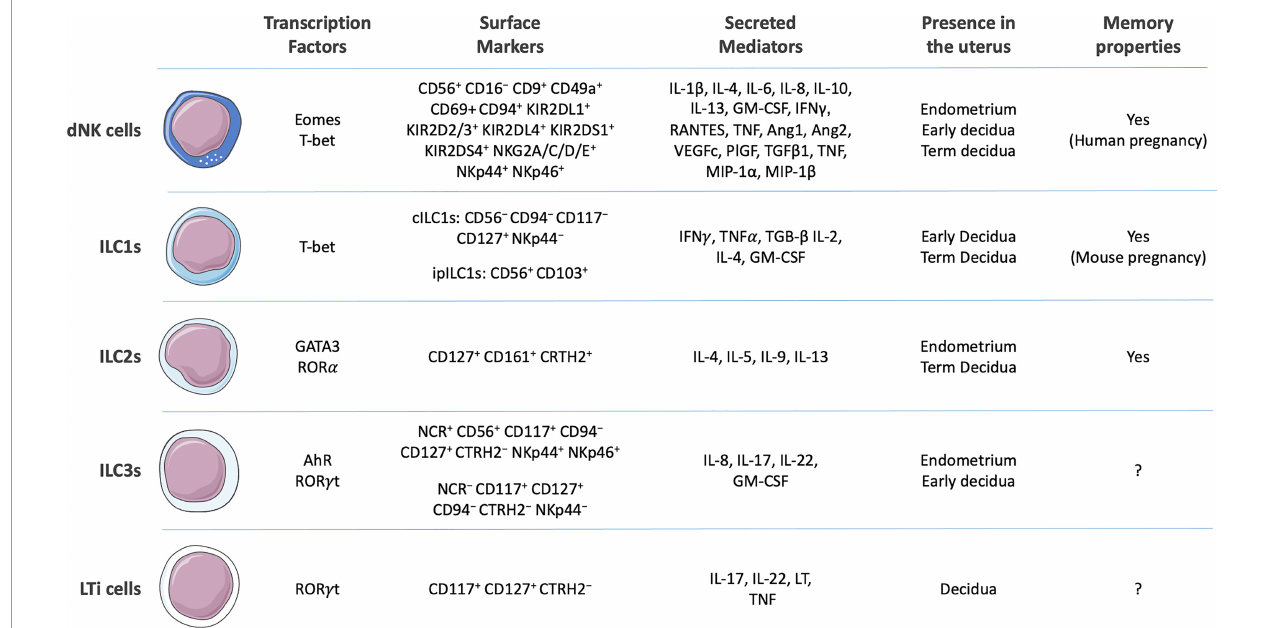
FIGURE 1 | Surface markers, secreted cytokines, presence in the uterine environment, and capacity to develop memory of human decidual Natural Killer (dNK) cells (12 – 14) and generic human innate lymphoid cells (ILCs) 1 [conventional ILC1s (cILC1s) and intraepithelial (ipILC1s)], ILC2s, ILC3s, and lymphoid tissue inducer (LTi) cells (11, 15 – 17). Composed with images from: Smart Servier Medical Art